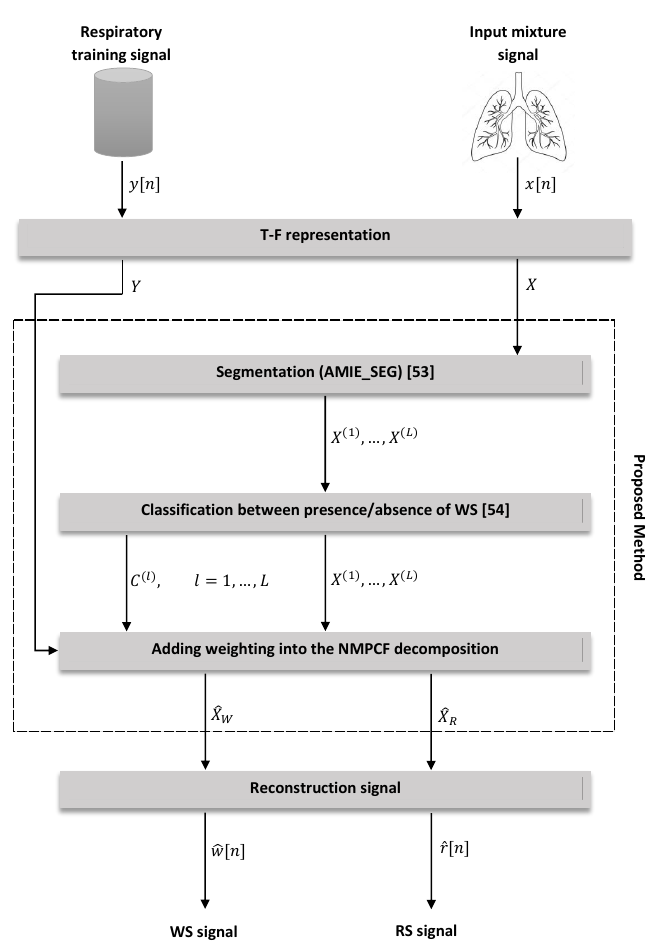
Figure 2. Flowchart of the proposed method